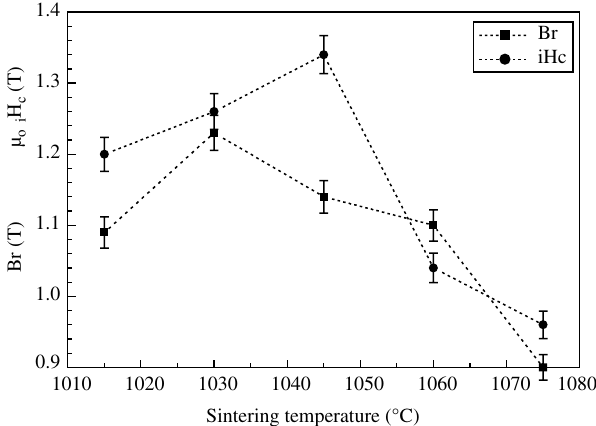
Fe B HD magnets prepared with a pow- 16 76 8